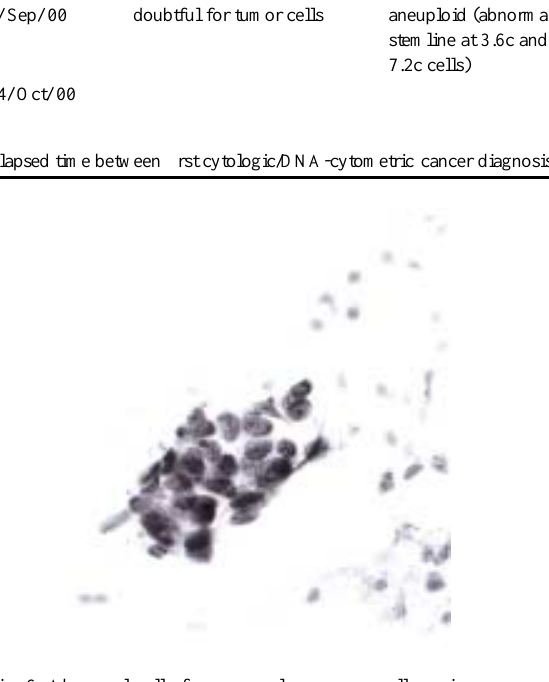
Fig. 6. Abnormal cells from an oral squamous cell carcinoma re- vealing nuclear polymorphism, chromatin clumping, nucleoli and in- creased nuclear-cytoplasmic ratio. Patient C. Original magnification 630 × .